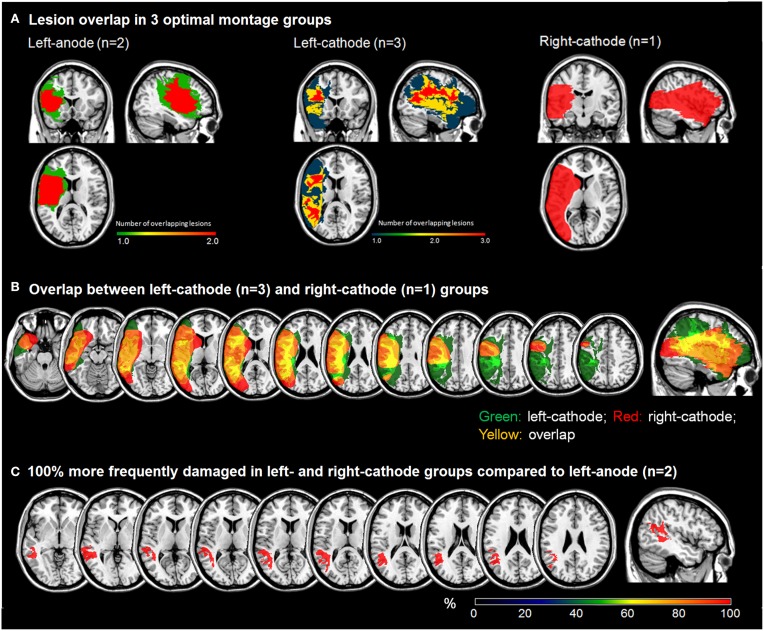
Phase 1: (A) Lesion overlap plots for different optimal montage-groups; (B) Lesion overlap between the cathodal montage groups; (C) Subtraction plot comparing left-anodal group to cathodal montage group.